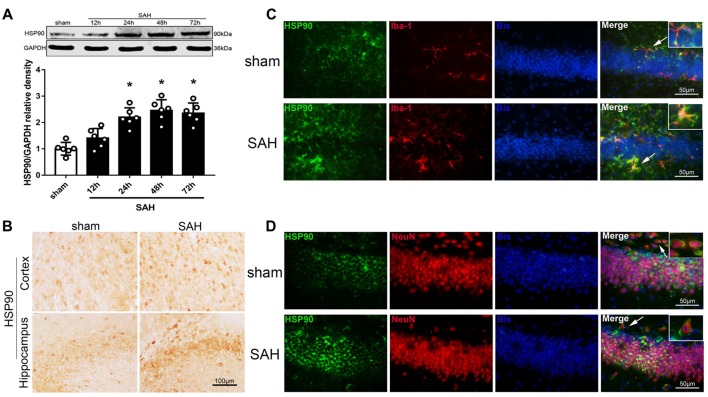
Expression of heat shock protein 90 (HSP90) after subarachnoid hemorrhage (SAH). (A) Representative western blot images and quantitative analyses of the HSP90 time course in the left hemisphere after SAH; n = 6 per group. (B) Immunohistochemistry staining for HSP90 in the left cortex and hippocampus. (C) Double immunofluorescence staining for HSP90 (green) in microglia (Iba-1, red) in the left hippocampus 48 h after surgery. (D) Double immunofluorescence staining for HSP90 (green) in neurons (NeuN, red) in the left hippocampus 48 h after surgery; n = 4 per group. *P < 0.05 vs. sham group. The error bars represent SD. Bis, bisbenzimide; Iba-1, ionized-calcium-binding adaptor molecule-1; NeuN, neuronal nuclear.